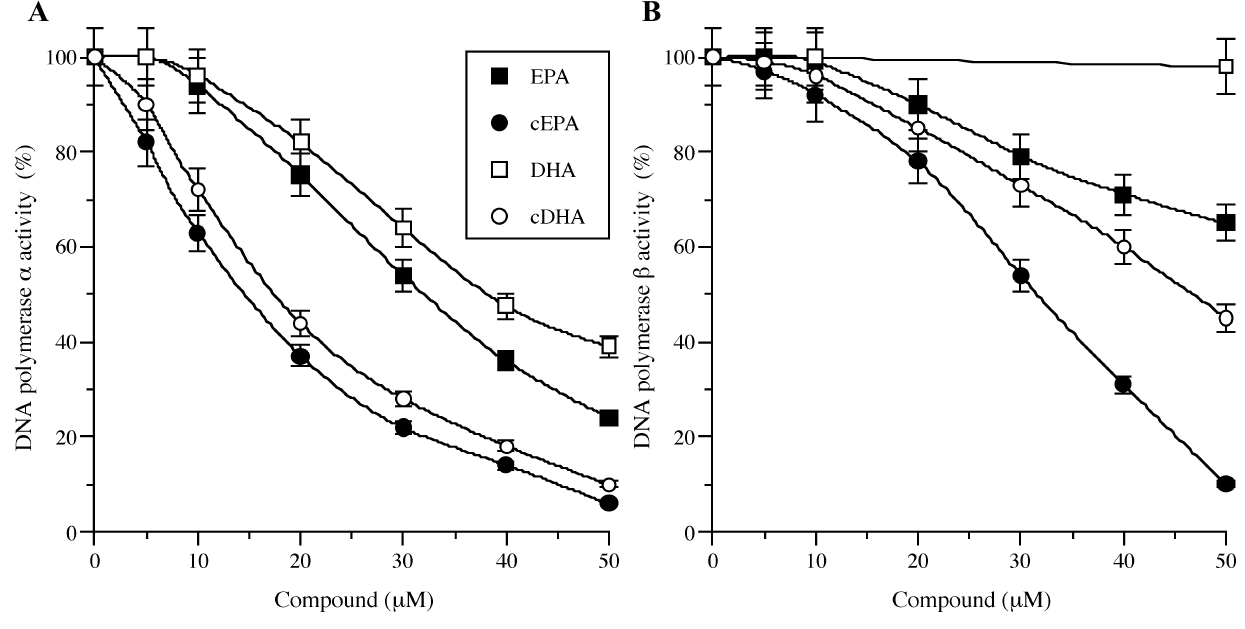
Figure 1. Dose-response curves of normal and conjugated PUFA for mammalian pol inhibition. (A) calf pol α and (B) rat pol β . Pol activity (0.05 units each) in the absence of the compounds was taken as 100 %. Values are shown as the means ± SEM of three independent